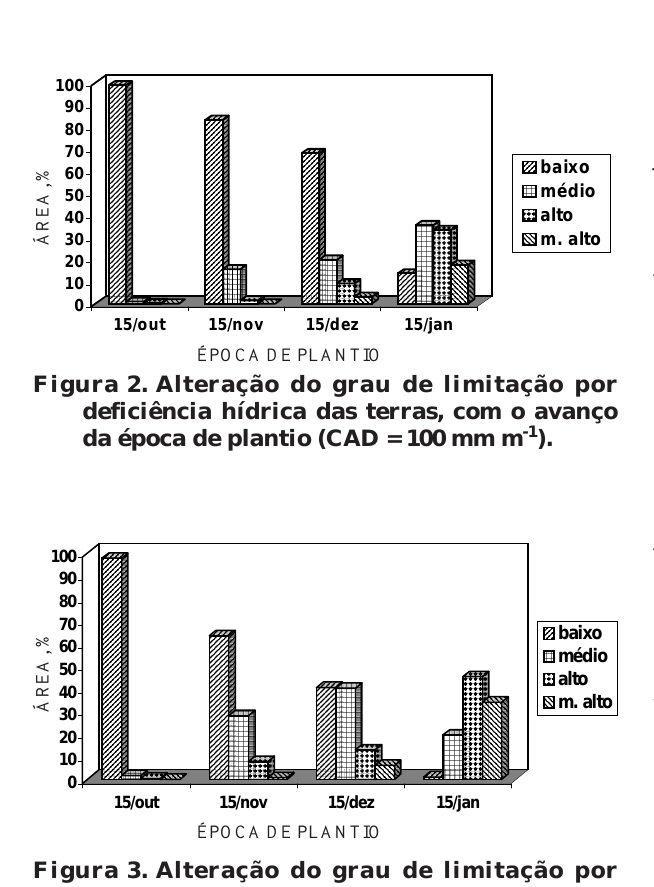
Figura 3. Alteração do grau de limitação por deficiência hídrica das terras, com o avanço da época de plantio (CAD = 73 mm m -1